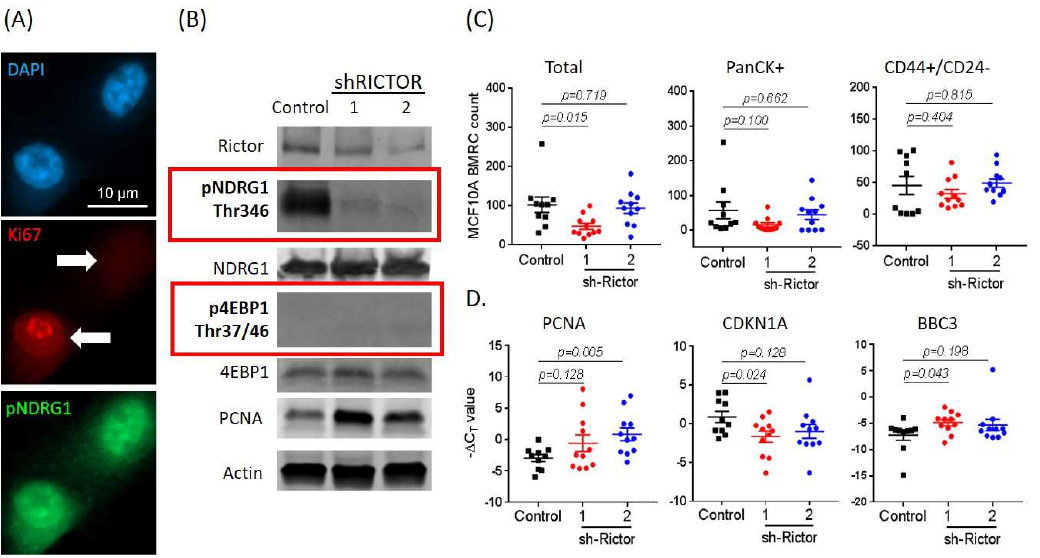
Figure 7. Inhibition of mTORC2 RICTOR decreases CTC proliferation markers. ( A ) High-definition immunofluorescence on MCF-10A cells showing differential expression of Ki67 proliferation marker, along with high pNDRG1 expression, indicative of active mTORC2 signaling (scale bar = 10μm). ( B ) Western blotting analyses of ShRNA RICTOR knockdowns of MCF10A cells showing that RICTOR knockdown resulted in decreased pNDRG1 expression, while p4EBP1 status remained unchanged (red boxes). Control denotes non-targeting scrambled control, and numbers 1 and 2 (below sh-RICTOR) denote two distinct lentiviral shRNA constructs against RICTOR. ( C ) (Top) Significant decrease of total BMRCs collected from ex vivo experiments using MCF-10A-shRICTOR knockdowns injected in NSG mice (1.0 × 10 5 cells/mouse; N = 11). Conversely, no change of PanCK+ or CD44+/CD24− BMRC cell populations was detected. ( D ) (Bottom) Real-time PCR of ex vivo MCF-10A shRICTOR BMRCs exhibit increased gene expression for PCNA (proliferation marker), along with decreased CDKN1A (quiescence status) and increased BBC3 (PUMA) expression, consistent with a pro-apoptotic response ( N = 11).